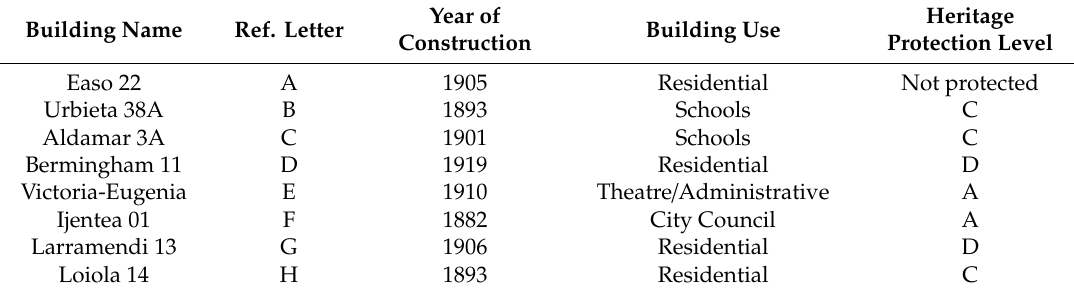
Table 4. List of the analyzed